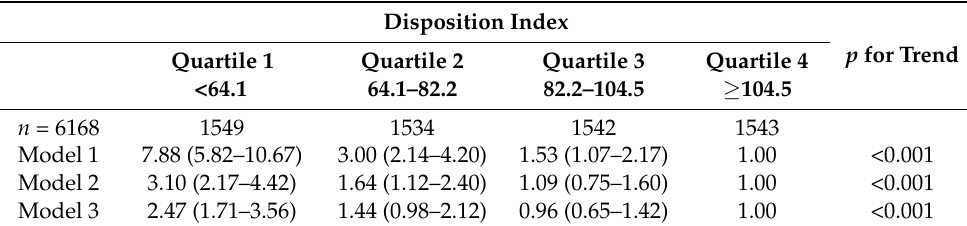
Table 5. Adjusted odds ratios (95% confidence intervals) of presence of moderate to severe hepatic steatosis according to disposition index quartiles using logistic